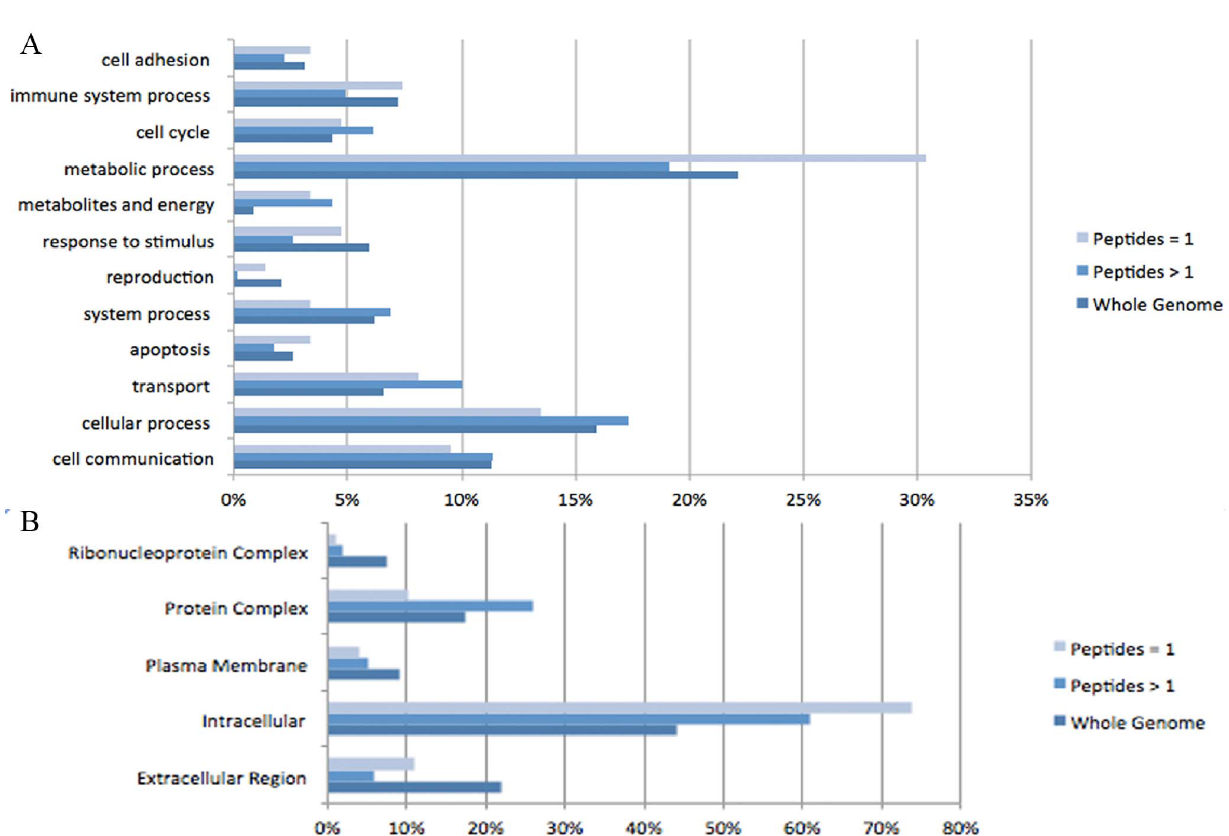
Figure 3. Functional distribution (A) and Sub-cellular distribution (B) of proteins identified with 1 peptide and 2 or more peptides compared to the entire Rattus norvegicus genome. Functional and spacial categories are those defined in the PANTHER database.